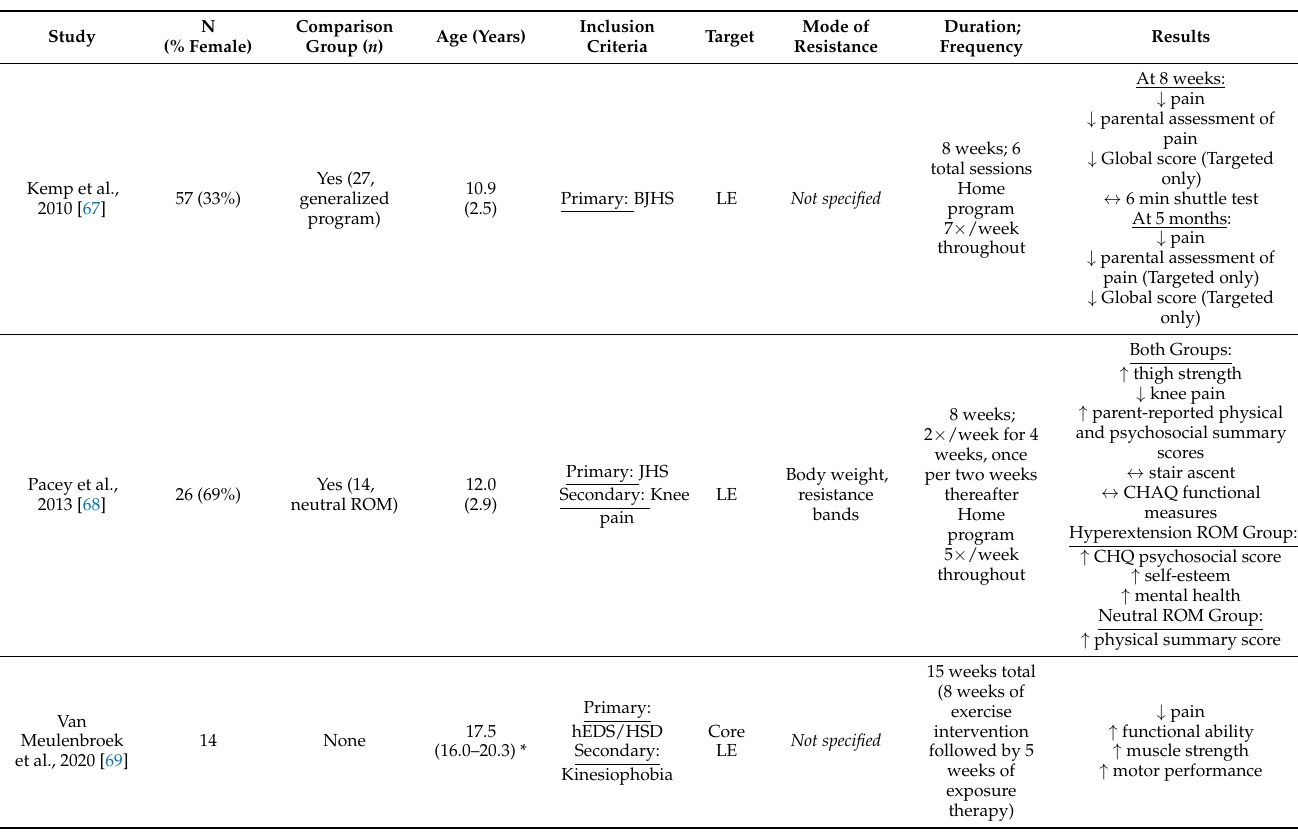
Table 2. Outcomes of Exercise Intervention Studies in Children and Adolescents with